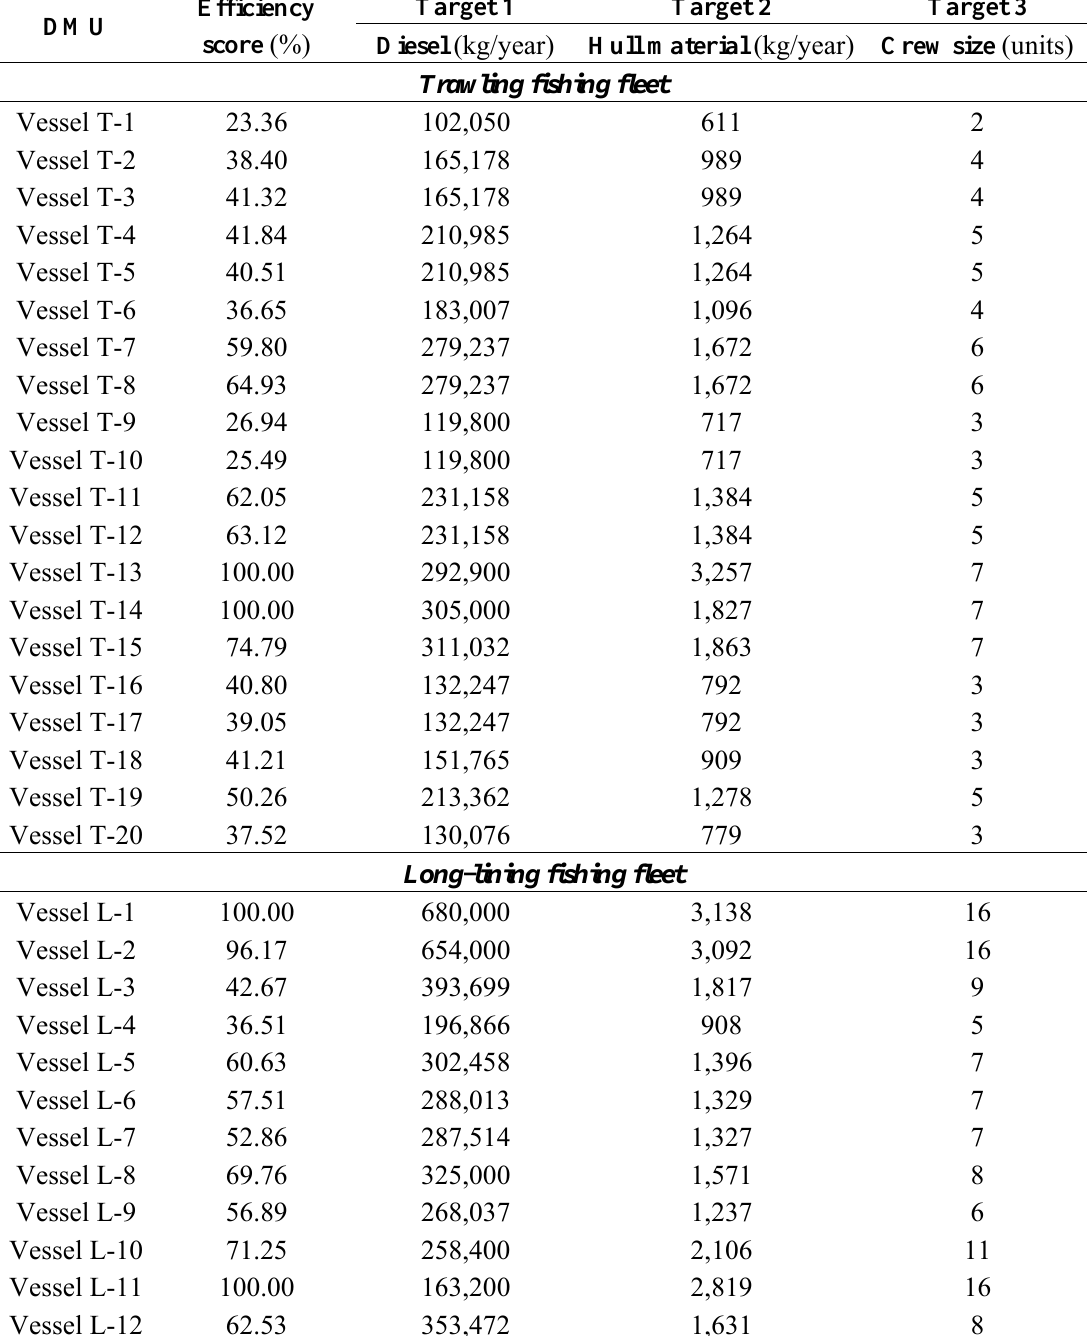
Table 2. Efficiency scores and target values for the illustrative case studies using the number of workers as an